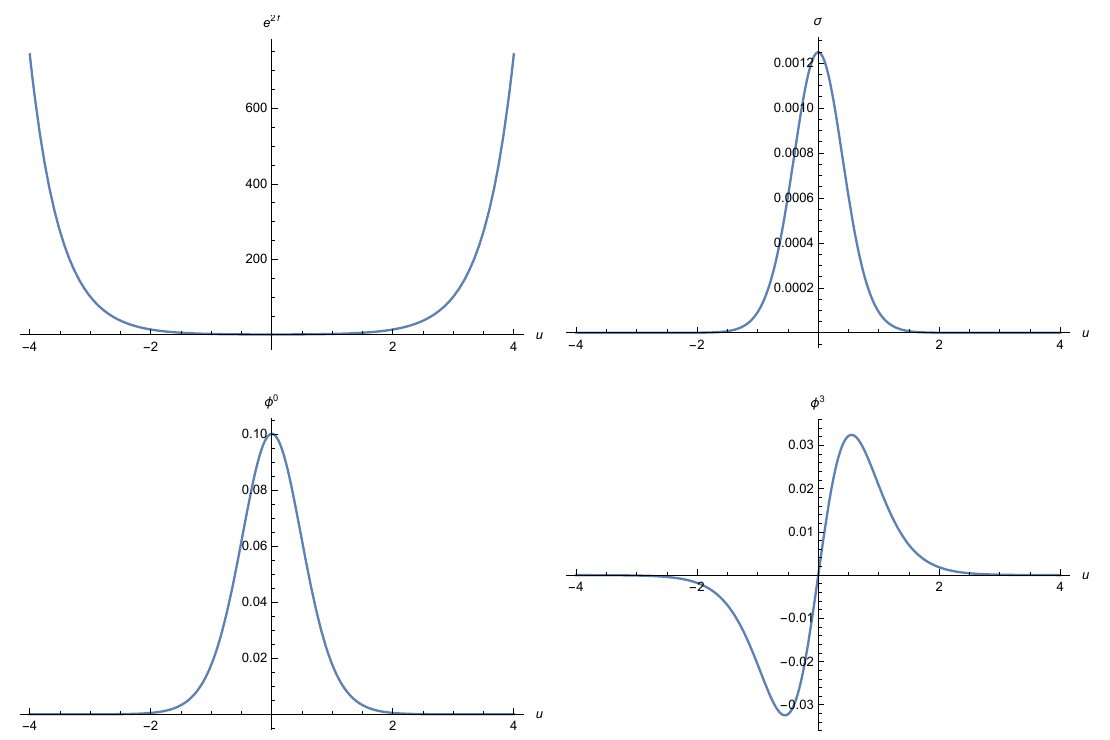
Figure 1 . Smooth Janus solutions for the four scalar (cid:12)elds. As mentioned in the main text, we take (cid:0) (cid:30) 3 with (cid:17) = +1 for u < 0, and (cid:30) 3 with (cid:17) = (cid:0) 1 for u >